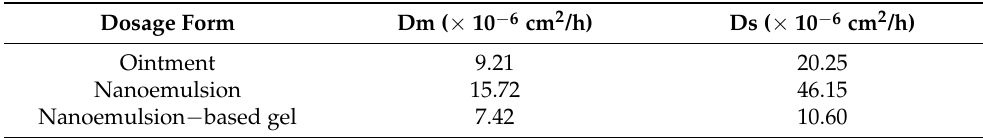
Table 5. Parameters of the numerical simulation model.